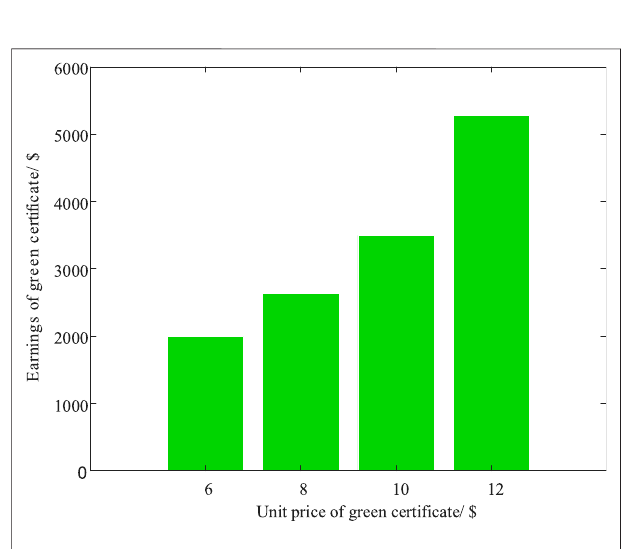
FIGURE 8 | Earnings under different green certi fi cate